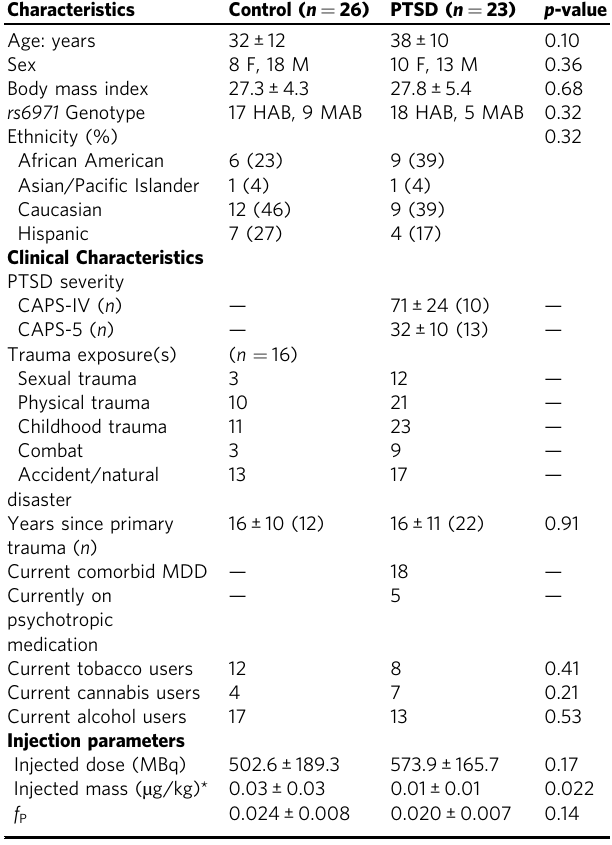
*signi fi cant at p <0.05; assessed from two - sided independent samples t -test. Values are Mean±SD, unless otherwise speci fi ed.